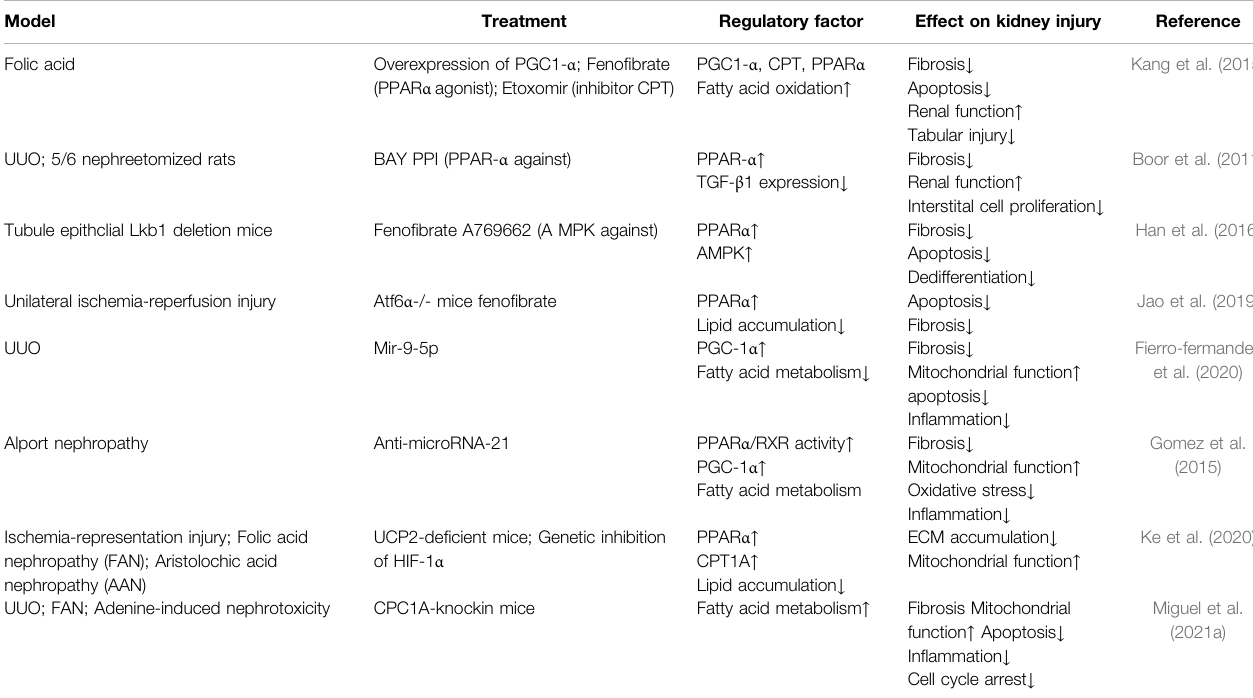
TABLE 2 | Intervene fatty acid β -oxidation in